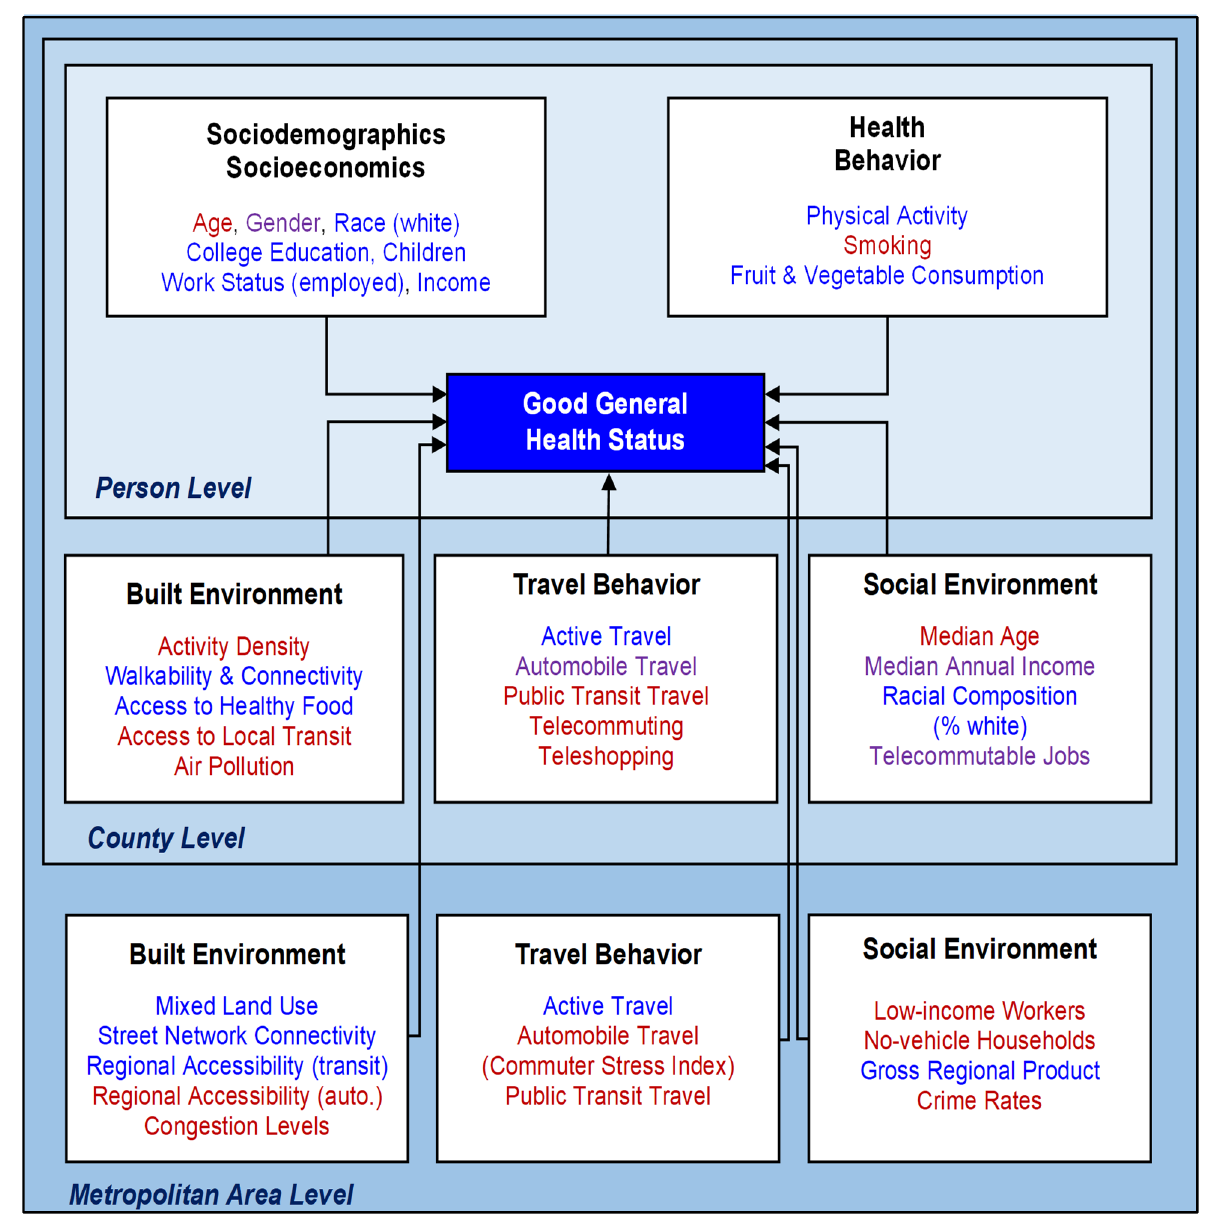
Figure 5. Infographic for summarized findings with regards to the respondents reporting a good general health status (Legend: Arrow indicates a correlation; blue font, positive correlation; red font, negative correlation; purple font, non-statistically significant correlation).